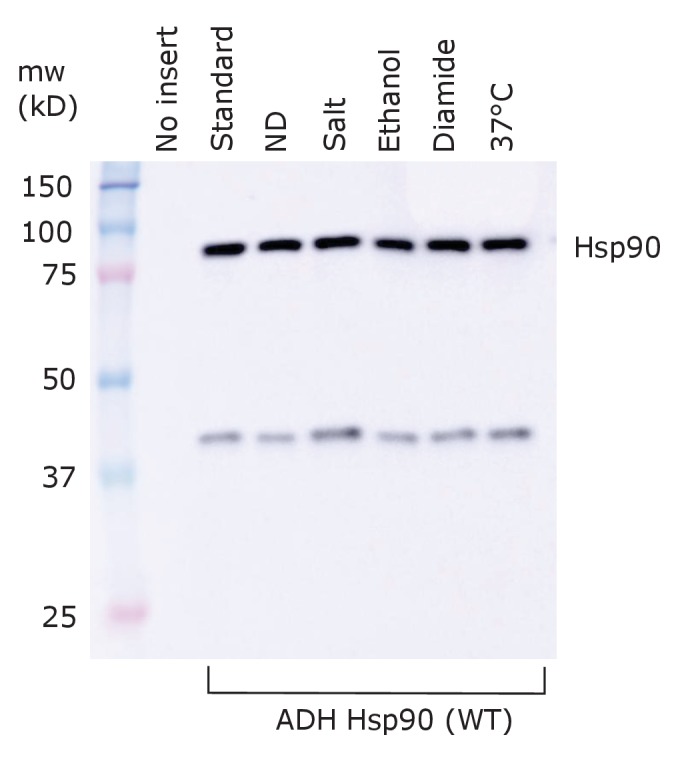
Hsp90 expression in the Hsp90 shutoff yeast strain harboring either wild-type Hsp90 under the constitutive ADH promoter or a null plasmid (no insert).Cells were grown for 12 hr in dextrose media at 30°C and then were transferred into the individual environmental conditions and grown for eight additional hours. Hsp90 levels were monitored by western blotting.